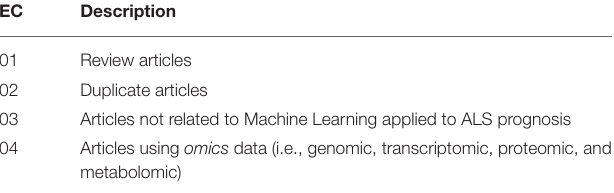
TABLE 3 | Exclusion